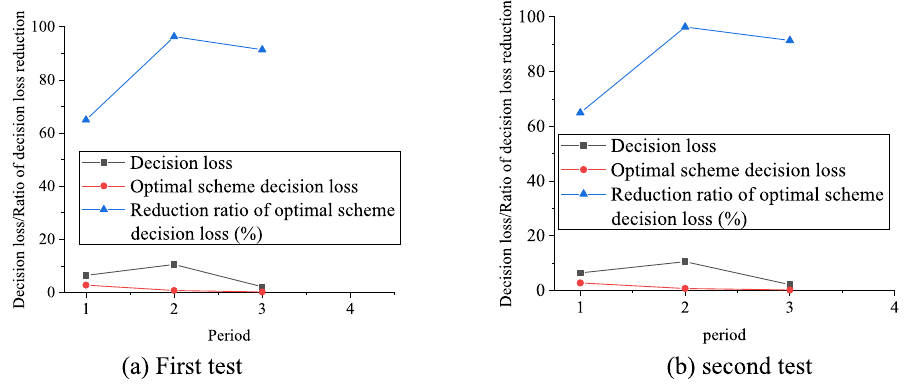
Figure 9. Decision loss of emergency material allocation scheme.